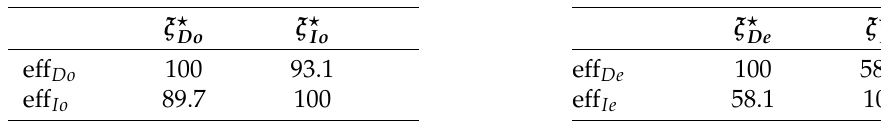
Table 1. Cross efficiencies, in percentage, of the D - and I -optimal designs using φ I and φ D for the homoscedastic and heteroscedastic models.